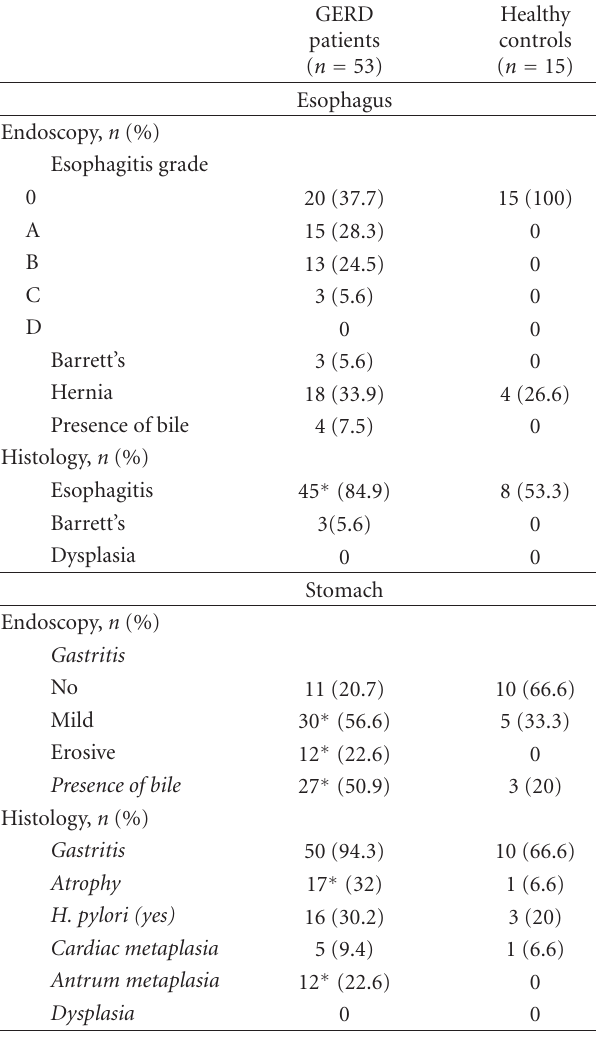
Table 2: Endoscopic and histologic data in GERD patients and healthy controls.